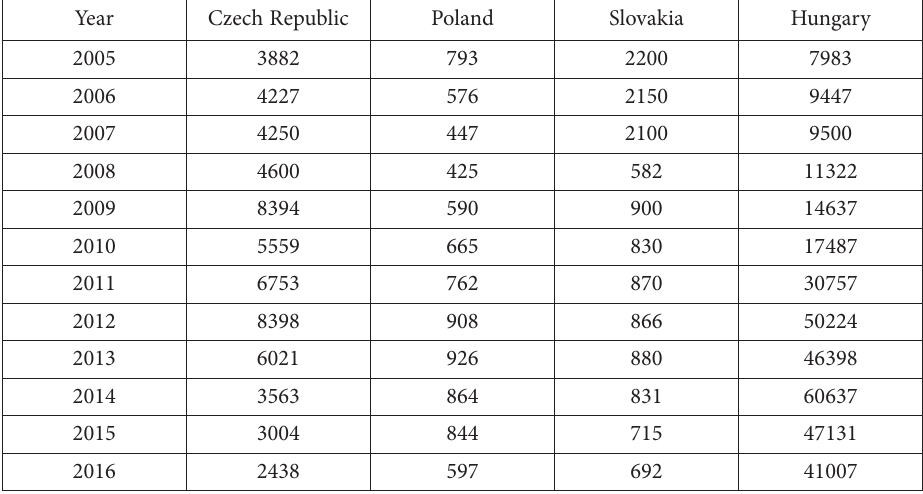
Table 1. The number of the bankruptcy of enterprises in the Visegrad Group countries in the years 2005–2016 (source: Own work on the basis of Creditreform.de,